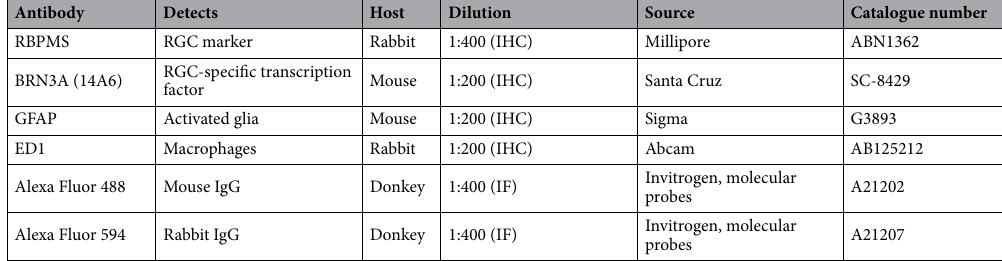
Table 1. Primary and secondary antibodies used in this study. IHC immunohistochemistry, IF